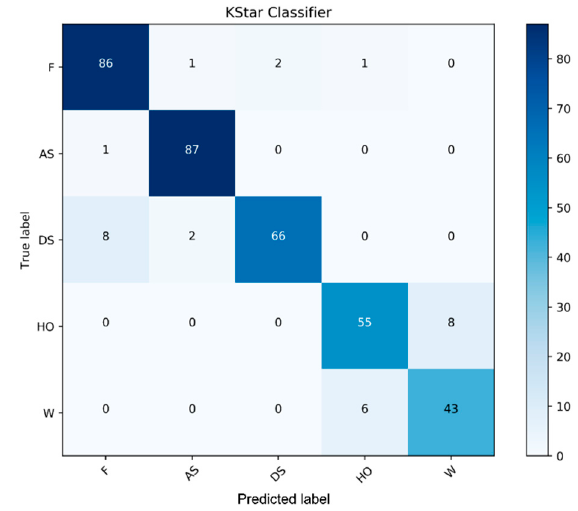
Figure 15. Confusion matrix (KStar classifier).